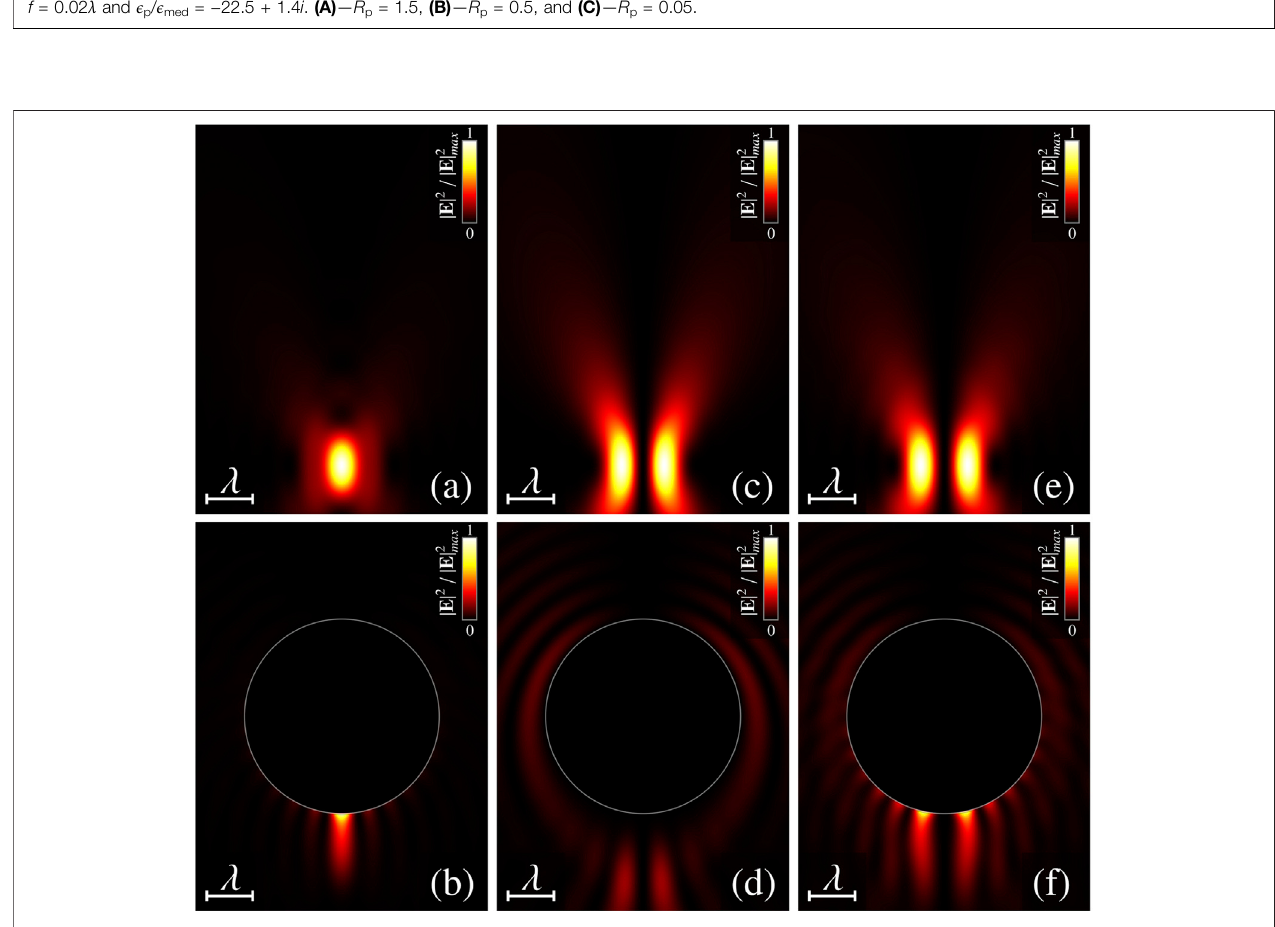
FIGURE 5 | Diffraction on the metal spherical particle: near- fi eld intensity distributions in the x - z plane (B, D, F) . Freely propagating wave (A, C, E) . z b (cid:2) 1.5 λ , R p (cid:2) 2 λ , ϵ p / ϵ med (cid:2) − 22.5 + 1.4 i , and f (cid:2) 0.3 (A, B) — LG 0,rad beam, (C, D) — LG 0,az beam, and (E, F) — LG + 0 , 1 beam.